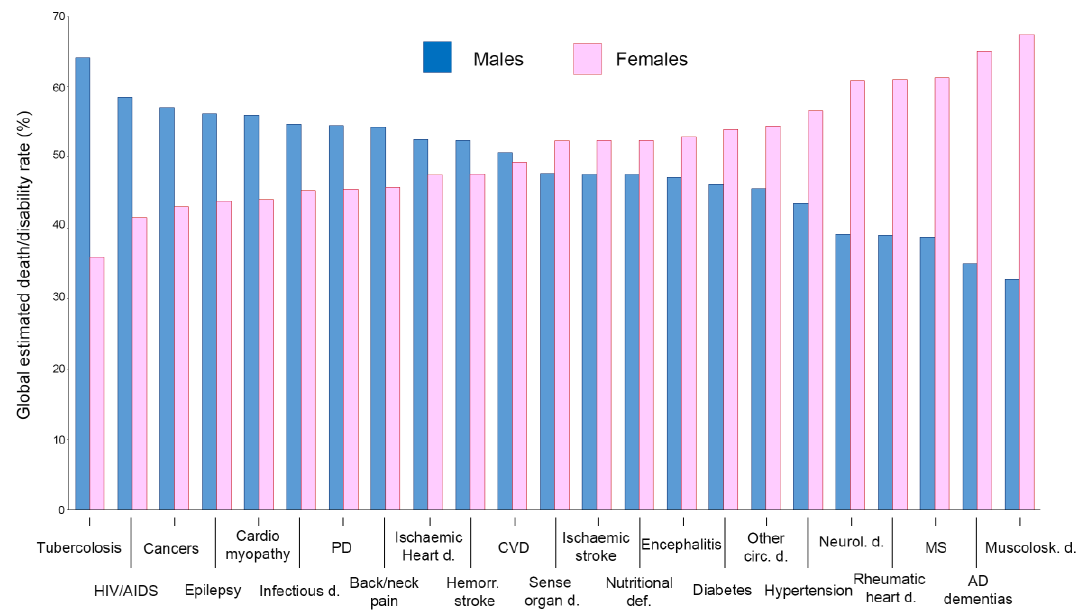
Figure 1. Modified from Global Health Estimated 2016 (www.who.int/healthinfo/global_burden_disease/en/). d.: disease; PD: Parkinson’s disease; Haemorr.: Haemorrhagic; CVD: Cardiovascular Disease; def.: deficiency; circ.: circulatory; neurol.: neurological; MS: Multiple Sclerosis; AD: Alzheimer’s Disease; Musculosk.: musculoskeletal. Sex and gender are concepts of primarily relevance in the real world, where disease morbidity, risk factors, onset age, clinical phenotype and treatments may strongly differ between males and females. While sex refers to biological and genetic features, gender includes roles and relationships